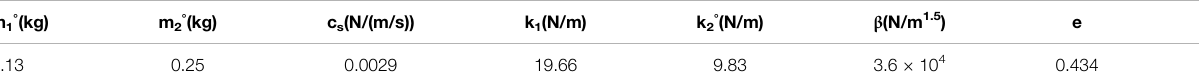
TABLE 3 | Parameters of simulation.